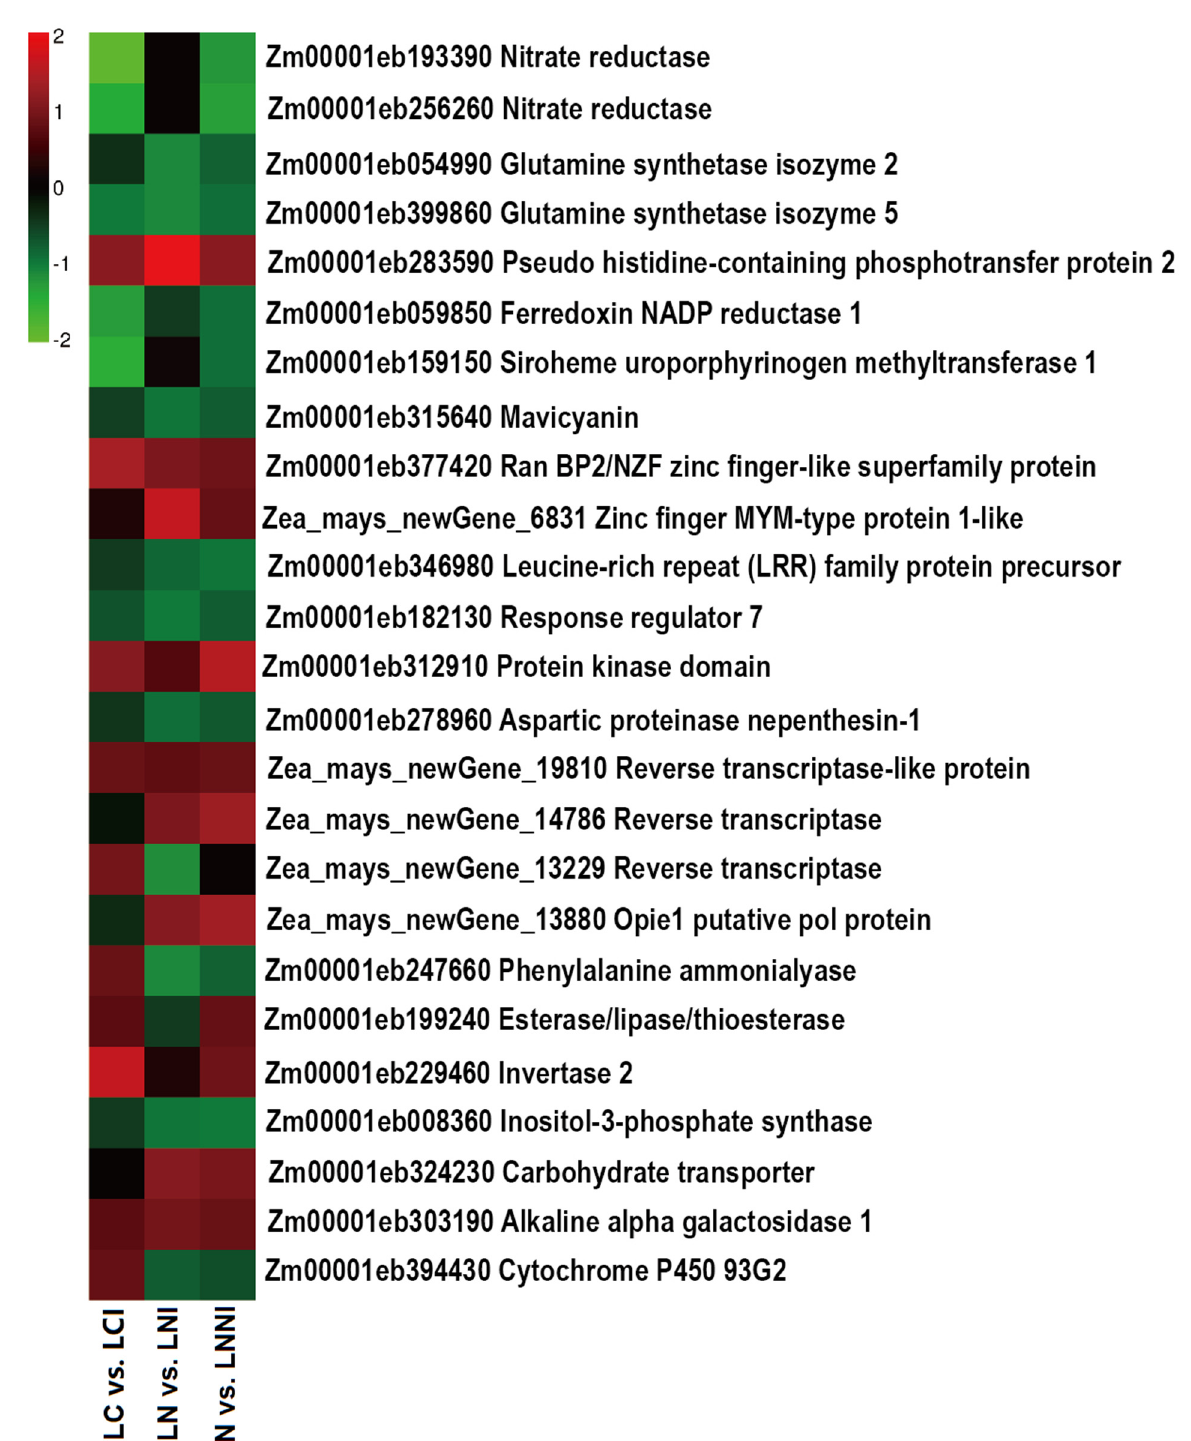
Figure 5. Expression profiling of DEGs in leaves of maize subjected to different nitrogen supplies and treated with 5 ppm IMI. Green to red means a down-regulated level to an up-regulated level (logFC).